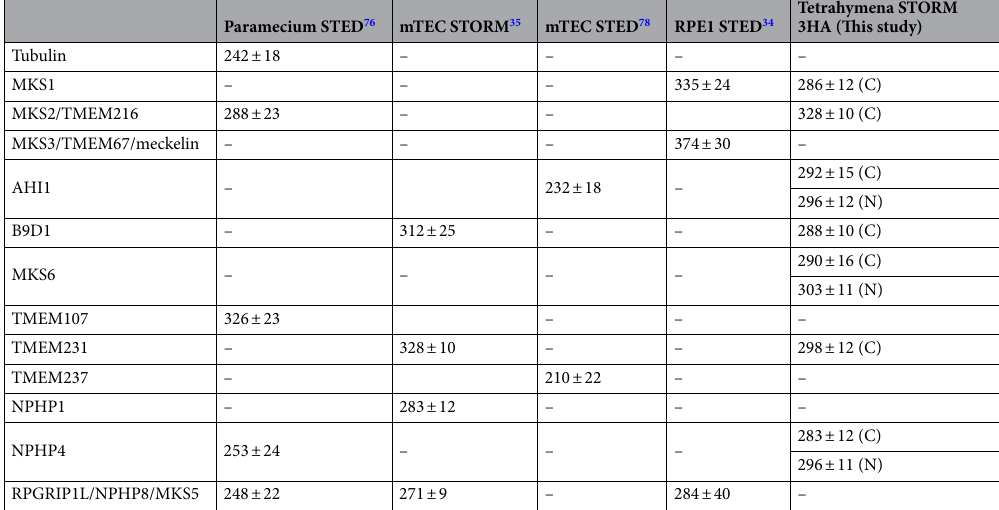
Table 1. Comparison of TZ proteins diameters in Tetrahymena and other